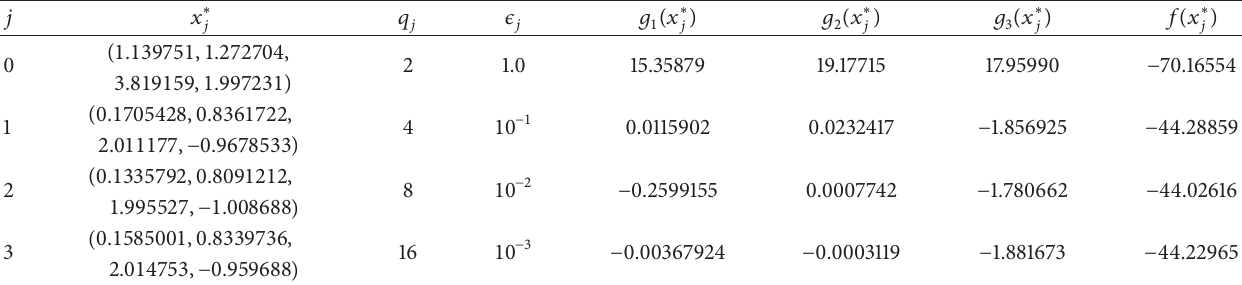
Table 4: Numerical results for Example 2 by Algorithm 7.